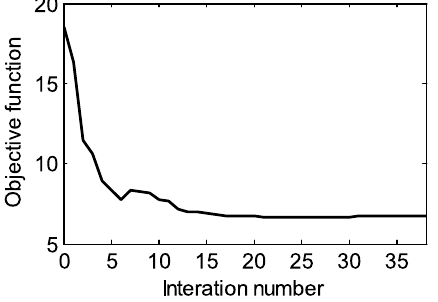
Fig. 5. Convergence history for the rectangular plate. Fig. 6. Displacement amplitude versus frequency at the loading point of the rectangular plate. Dot line represents bare plate, solid line rep- resents plate with optimized PCLD layout and dot-dash line represents plate with PCLD fully covered.